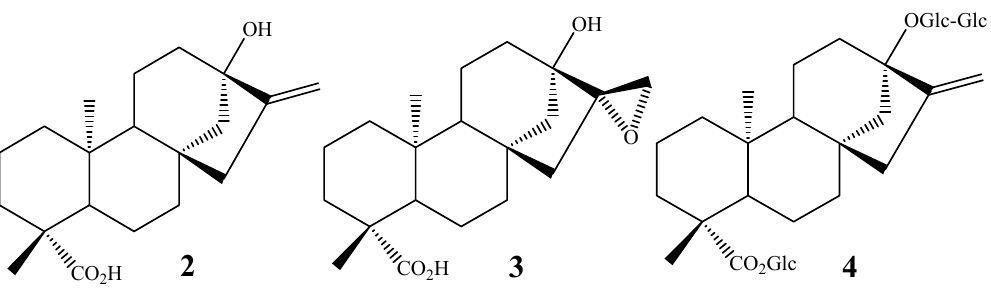
Figure 2. Chemical structures of steviol ( 2 ), steviol 16 α ,17-epoxide ( 3 ) and stevioside ( 4